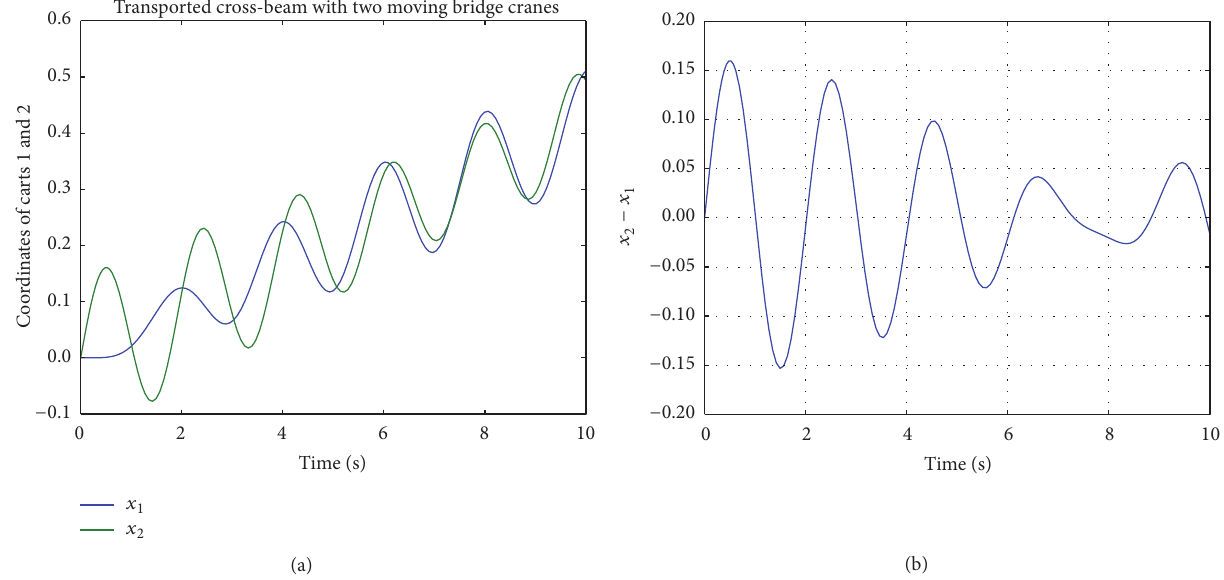
Figure 4: JModelica.org-derived numerical plots for linear coordinates 𝑥 1 = 𝑥 1 (𝑡) ; 𝑥 2 = 𝑥 2 (𝑡) (a); and 𝑥 2 − 𝑥 1 = 𝑥 2 (𝑡) − 𝑥 1 (𝑡) (b), computed for system (13) with nonzero initial velocities 𝑉 𝐵 (0) = 0.5 (m/s) and 𝜔 𝛽 (0) ≈ −0.083